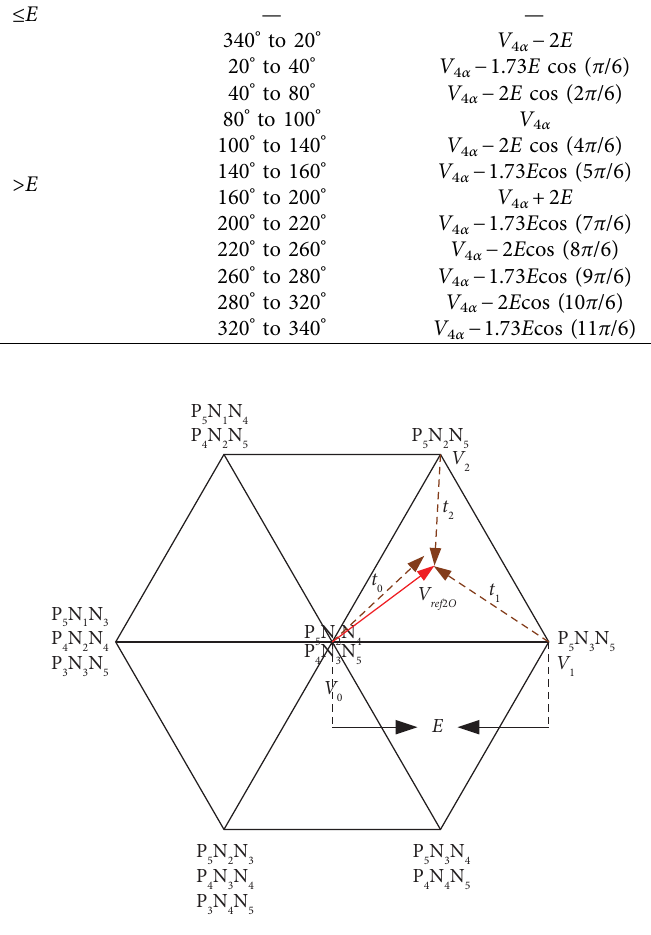
Figure 7: Outer 2L hexagon-3 with switching